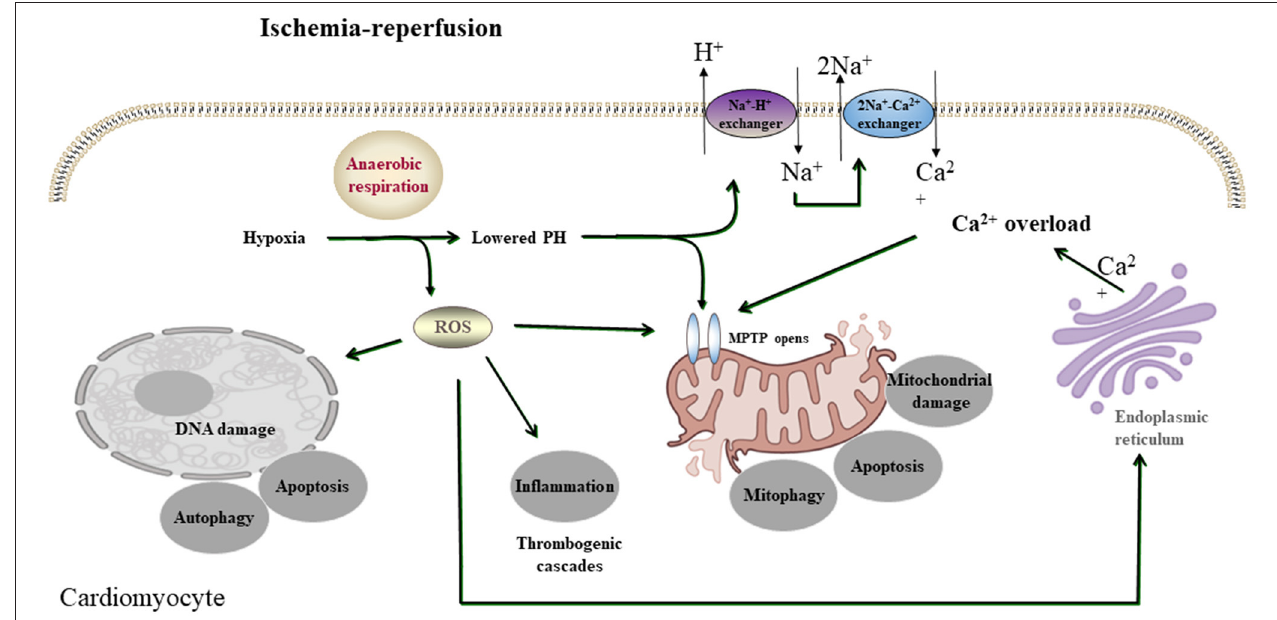
FIGURE 1 | A simplified scheme of the mechanism of acute myocardial I/R injury. During acute myocardial ischemia, ischemic cardiomyocytes switch to anaerobic metabolism to provide ATP. However, this results in the Na + -H + exchanger to extrude H + and results in intracellular Na + overload, which activates the 2Na + -Ca2 + exchanger to function in reverse to extrude Na + and leads to intracellular Ca2 + overload. The endoplasmic reticulum also markedly reduces Ca2 + reuptake, which exacerbates intracellular Ca2 + overload. Ca2 + can also induce MPTP opening. During reperfusion, the influx of oxygen fuels production of ROS (oxygen paradox). Other sources of ROS include xanthine oxidase (endothelial cells) and NADPH oxidase (neutrophils). ROS can damage virtually every biomolecule found in cells, promote the opening of mPTPs, and activate inflammatory and thrombogenic cascades to exacerbate cell